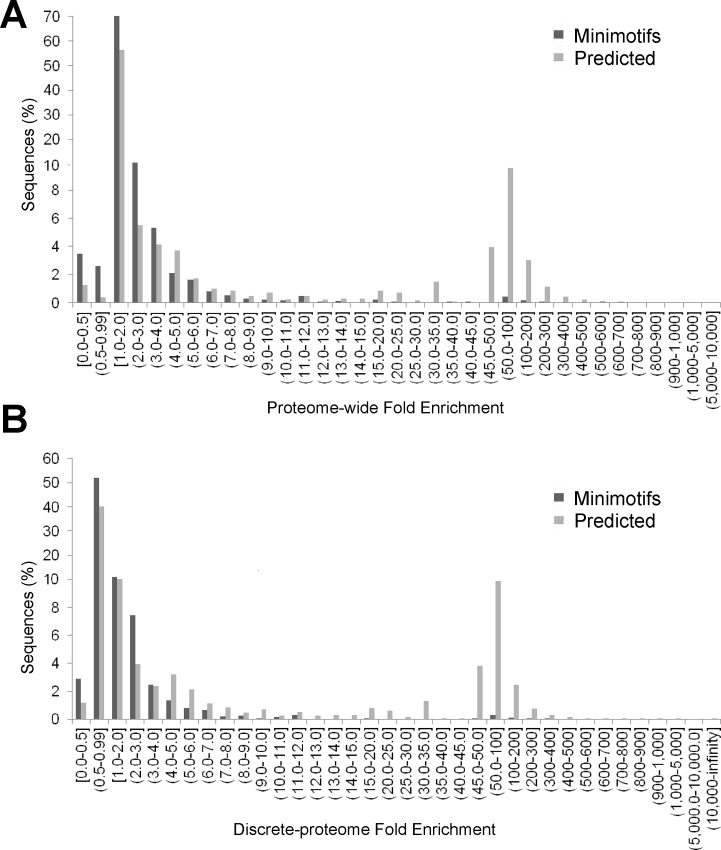
Fold-enrichment scores of minimotifs and predicted sequences.Bar graph showing the percentage of occurrences with different proteome-wide (A), and discrete-proteome (B) fold-enrichments. Dark gray bars represent the percentage of C-terminal minimotifs, and light gray bars represent the percentage of predicted consensus sequences and instances from de novo generated sequences.